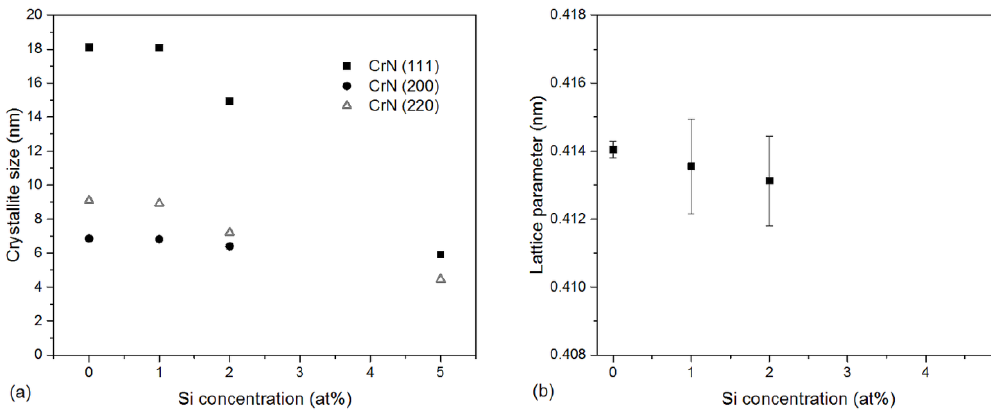
Figure 5. The crystallite size ( a ) and the lattice parameter ( b ) of the AlCrSiN coatings formed from cathodes with silicon concentrations ranged from 0 to 10 at%.